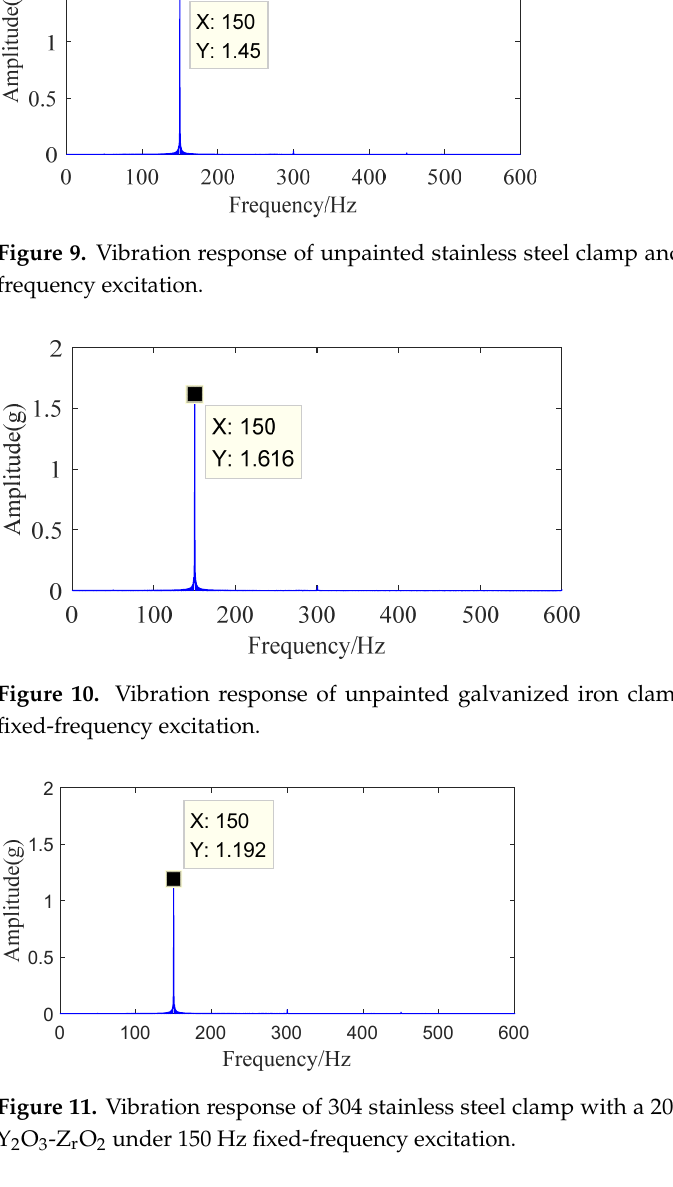
Figure 12. Vibration response of galvanized iron clamp with a 200- μ m-thick hard coating of Al-Cu- Fe-Cr under 150 Hz fixed-frequency excitation. Figure 13. Vibration response of 304 stainless steel clamp with a 200- μ m-thick hard coating of Z r O 2 - PTFE under 150 Hz fixed-frequency excitation. Figure 14. Vibration response of galvanized iron clamp with a 150- μ m-thick hard coating of Z r O 2 - PTFE under 150 Hz fixed-frequency excitation.